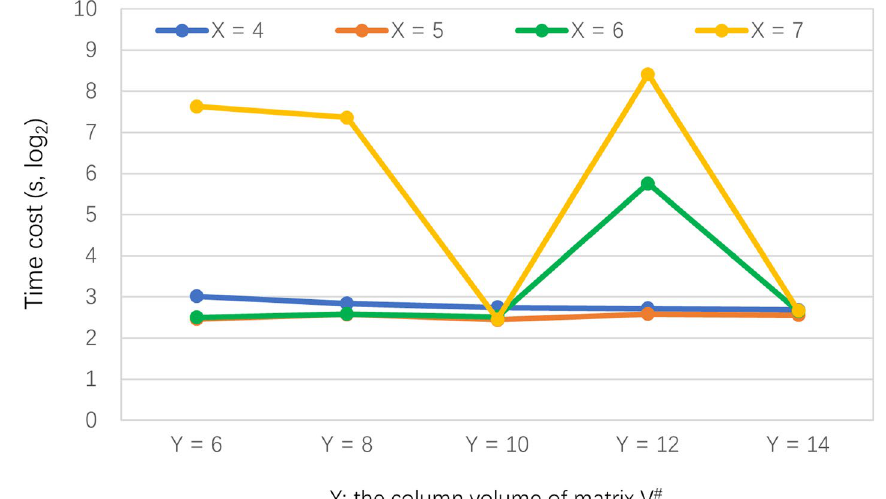
Fig. 6 Time cost of FSPLO w.r.t. ( X , Y